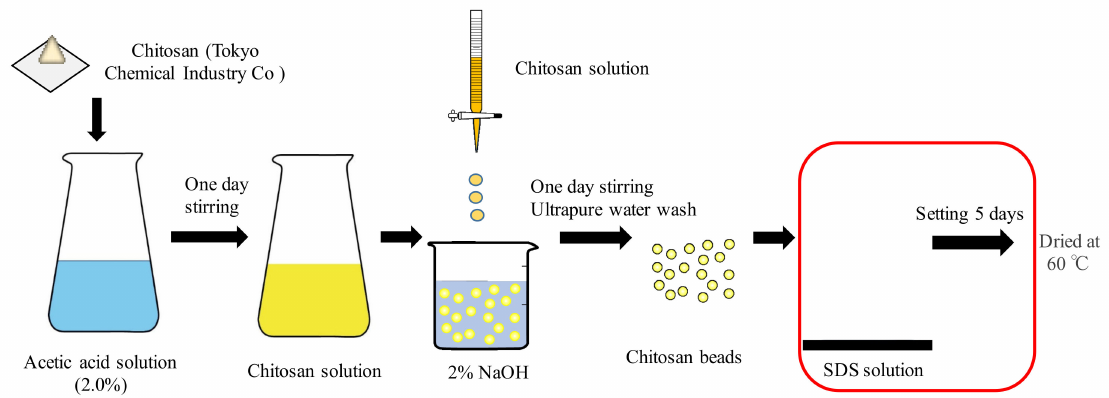
Figure 1. Procedure employed for the synthesis of sodium dodecyl sulfate (SDS)-chitosan